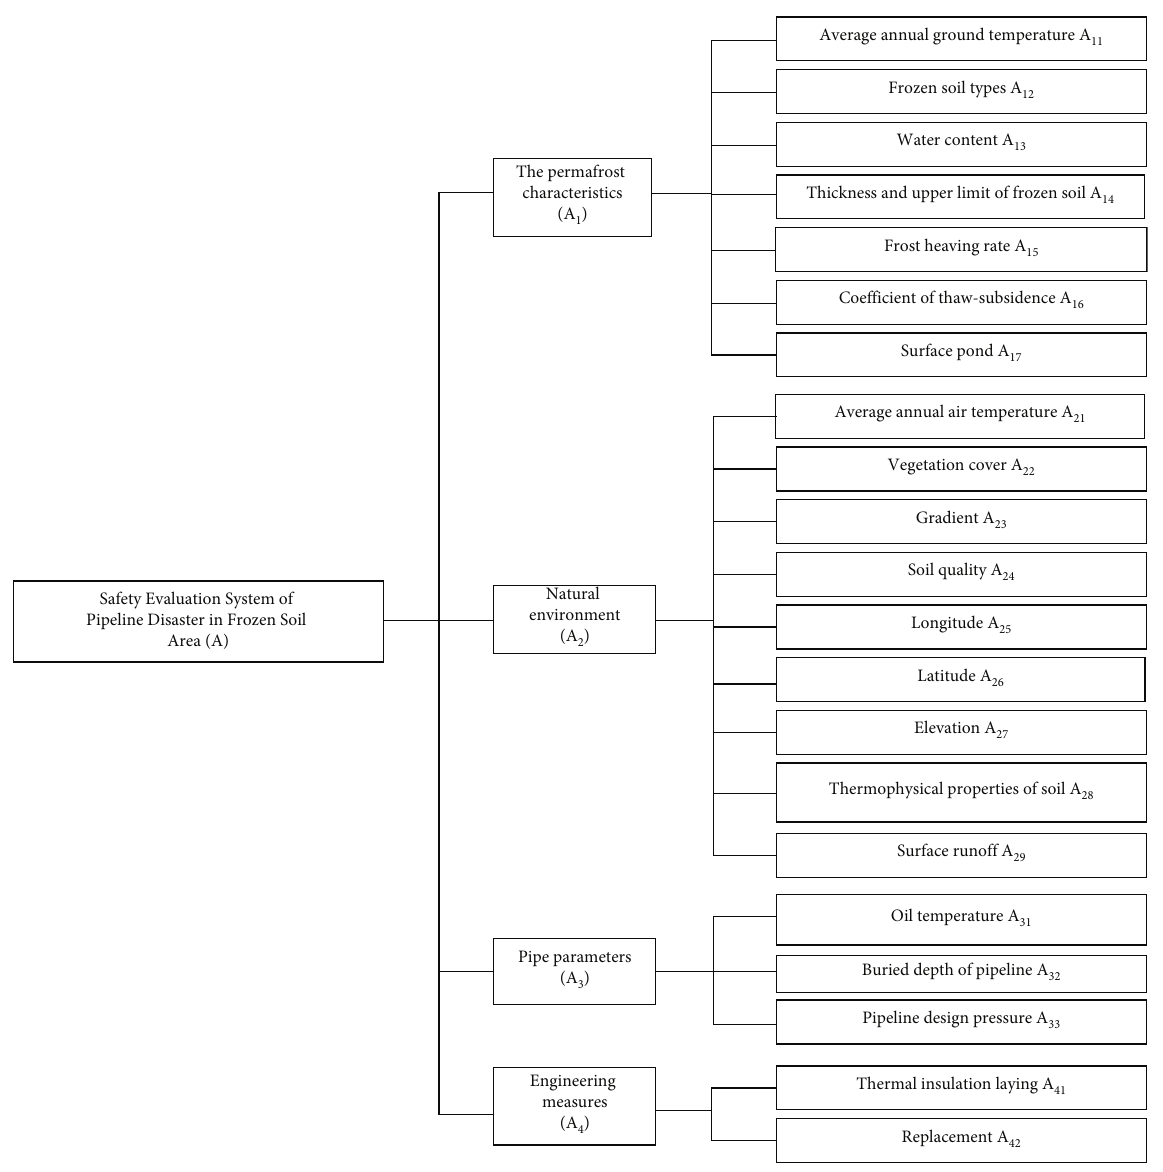
Figure 1: Structure of pipeline disaster safety evaluation index system in China-Russia crude oil permafrost